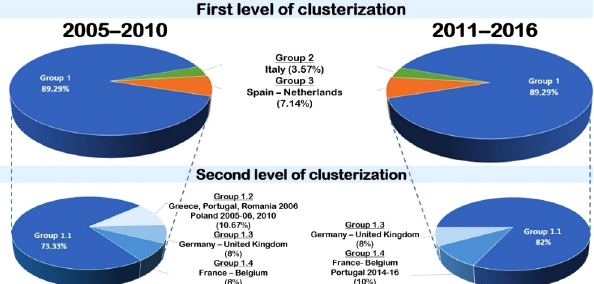
Figure 2. Chained clusters obtained through the two-stage cluster analysis (2005–2010 vs 2011–2016) (source: own elaboration)